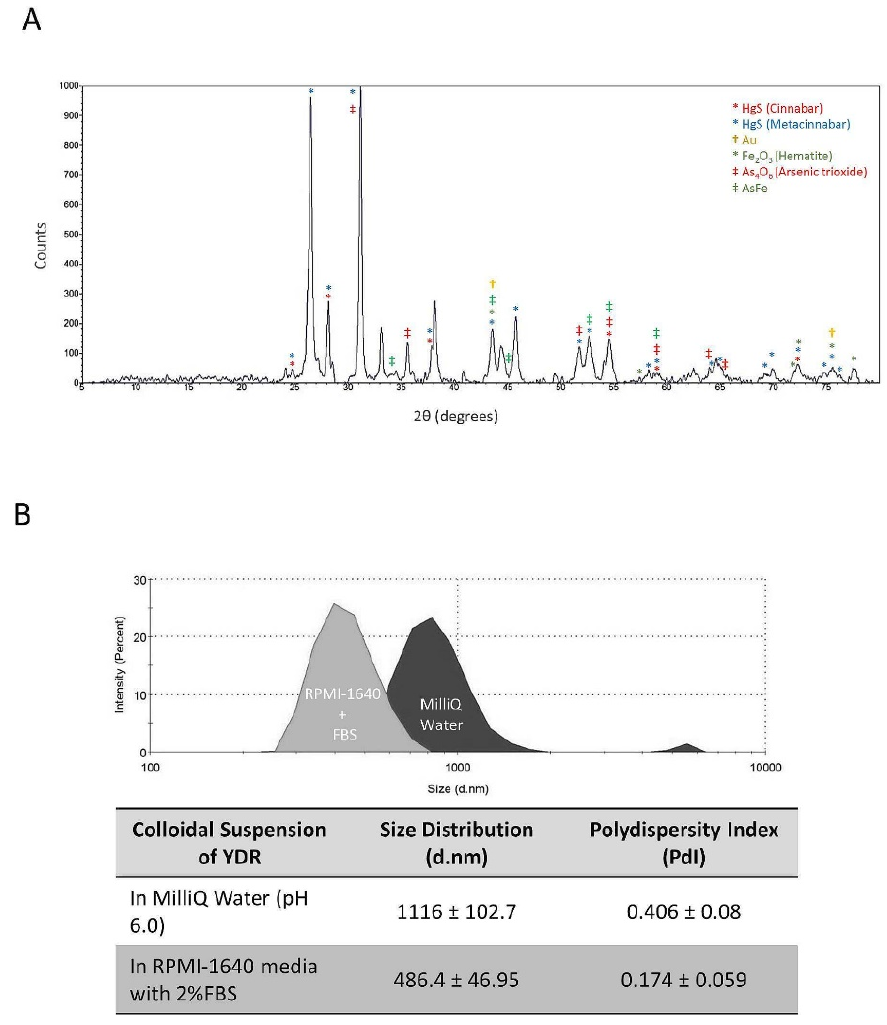
Figure 3. X-ray diffraction (XRD) and size distribution analysis of dry Yogendra Ras (YDR) sample. ( A ) XRD analysis showed the presence of cinnabar (HgS), metacinnabar (HgS), pure gold (Au), hematite (Fe 2 O 3 ), arsenic trioxide (As 4 O 6 ), and arsenic-iron alloy (AsFe). ( B ) Dynamic light scattering analysis of the YDR showed them to be present in a bimodal phase when suspended in pure MilliQ water. The size distribution showed the presence of particles with a hydrodynamic diameter of 1116 ± 102.7 d.nm along with a high polydispersity index (PdI) value representing an unstable colloidal suspension. When the YDR particles were suspended in cell culture media containing 2% FBS, the particle size distribution changed to a monomodal distribution showing the hydrodynamic diameter of 486 ± 46.95 d.nm and a lower PdI value representing a stable colloidal suspension.